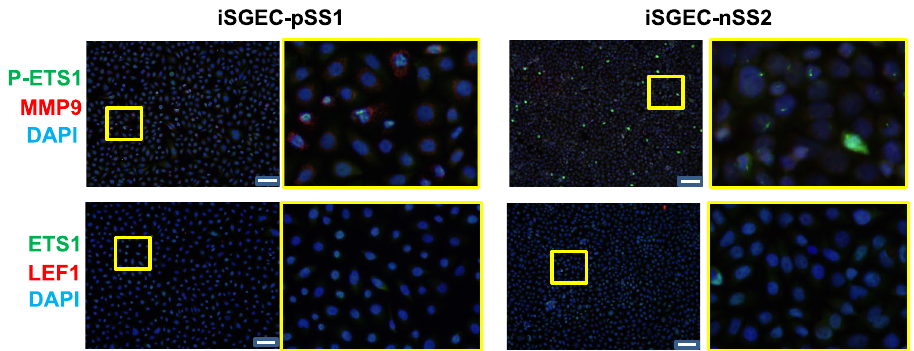
Figure 4. Characterization of epithelial and progenitor cell markers in iSGECs by immunofluorescence. iSGEC-pSS1 (left) and iSGEC-nSS2 (right) were cultured on gelatin coated 8-well tissue culture slides for 48–72 h. Phosphorylated ETS1 (Thr38) (P-ETS1) displayed greater overall nuclear localization and intensity in iSGEC-nSS2 and was co-expressed with increased MMP9 levels in iSGEC-pSS1. ETS1 and LEF1 demonstrated relatively low expression levels in iSGECs when assessed by IF. iSGEC-nSS2 cells expressed Phos(T38)-ETS1 uniformly as small nuclear bodies interspersed with high- expressing whole-cell localized Phos(T38)-ETS1, regardless of MMP9 levels. The overall intensity and localization of ETS1 and LEF1 was unremarkable in either cell line or highlighted obvious differences in some cells. Representative regions (yellow) are highlighted and displayed adjacent their respective image. Images were captured at 20 × magnification and white scale bars represent 100